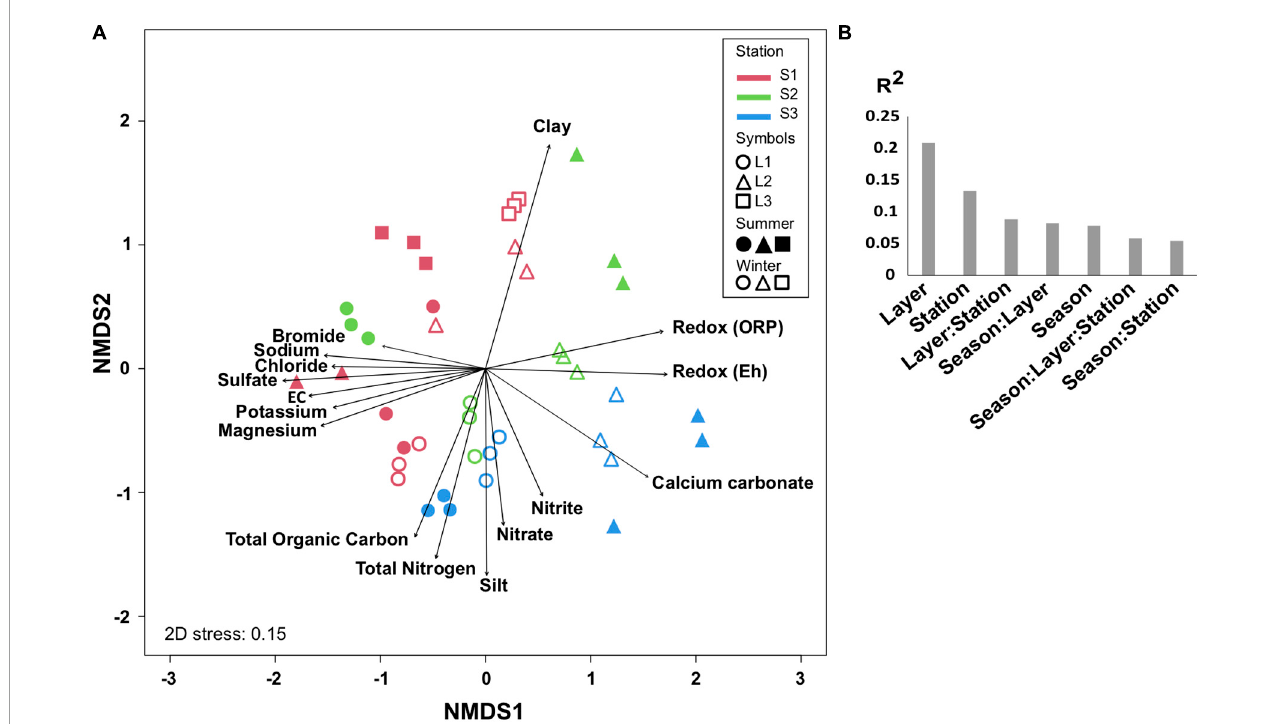
FIGURE3 Comparison of microbial communities. (A) Non-metric multidimensional scale (NMDS) at OTU level in different layers (L1, L2, L3 or L1, L2) from each station (S1, S2, S3) at summer (S, dry period) and winter (W, wet period). The significant environmental variables are represented by vectors. (B) PERMANOVA partitioning ( R 2 value, p < 0.001) according to layers, stations, seasons, and their interactions. Three biological replicates (except for S.S1.L2, n = 2) were analyzed per